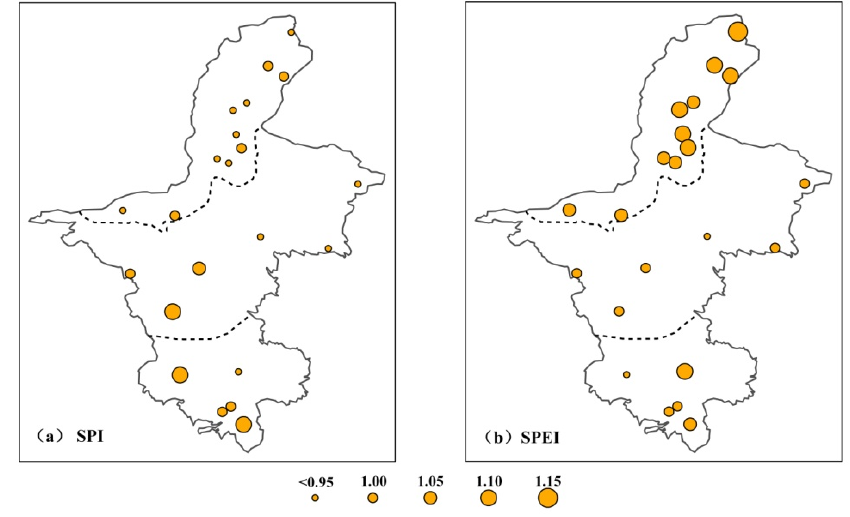
Figure 7. Average drought intensity calculated from monthly SPI/SPEI values at the 3-month time scale for 22 stations during the years 1972–2011 in Ningxia. ( a ) SPI, ( b )